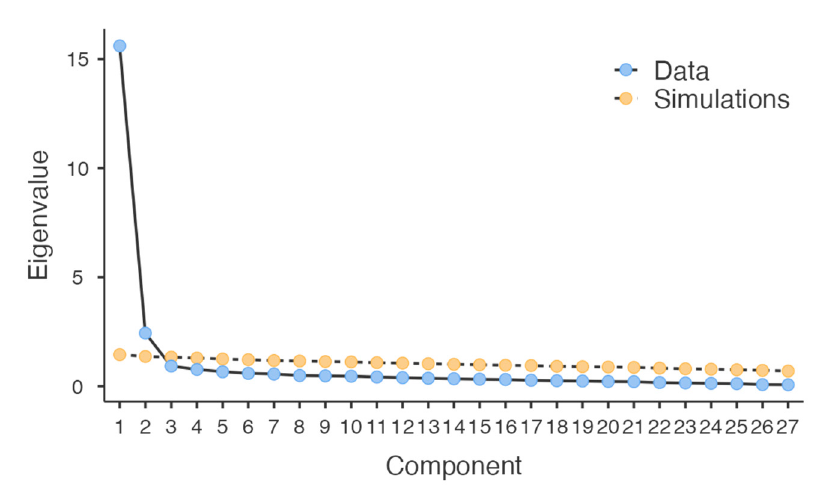
Figure 1. Scree plot resulting from the parallel analysis.